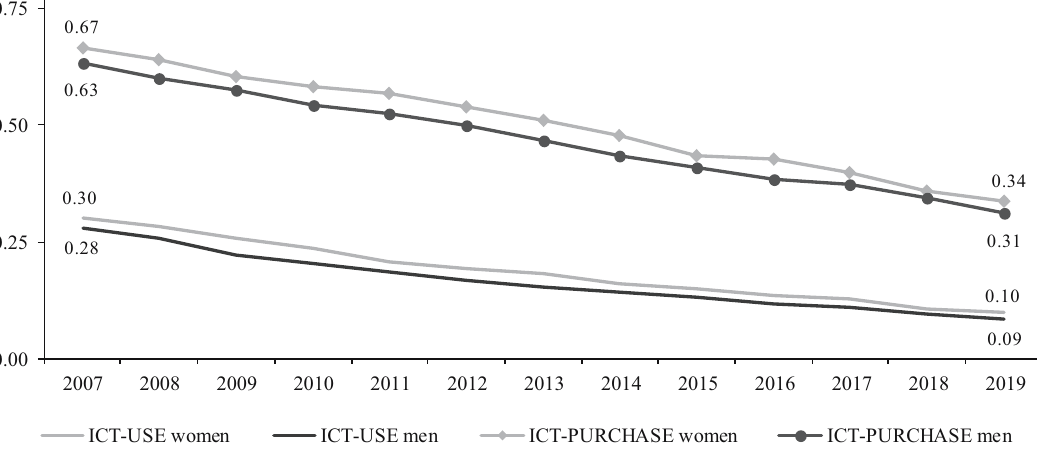
Figure 5: σ - convergence of ICT indicators in the EU - 28, 2007 – 2019. Note: Evolution of the standard deviation. Source: Own elaboration from Digital Economy & Society Database ( Eurostat ) .